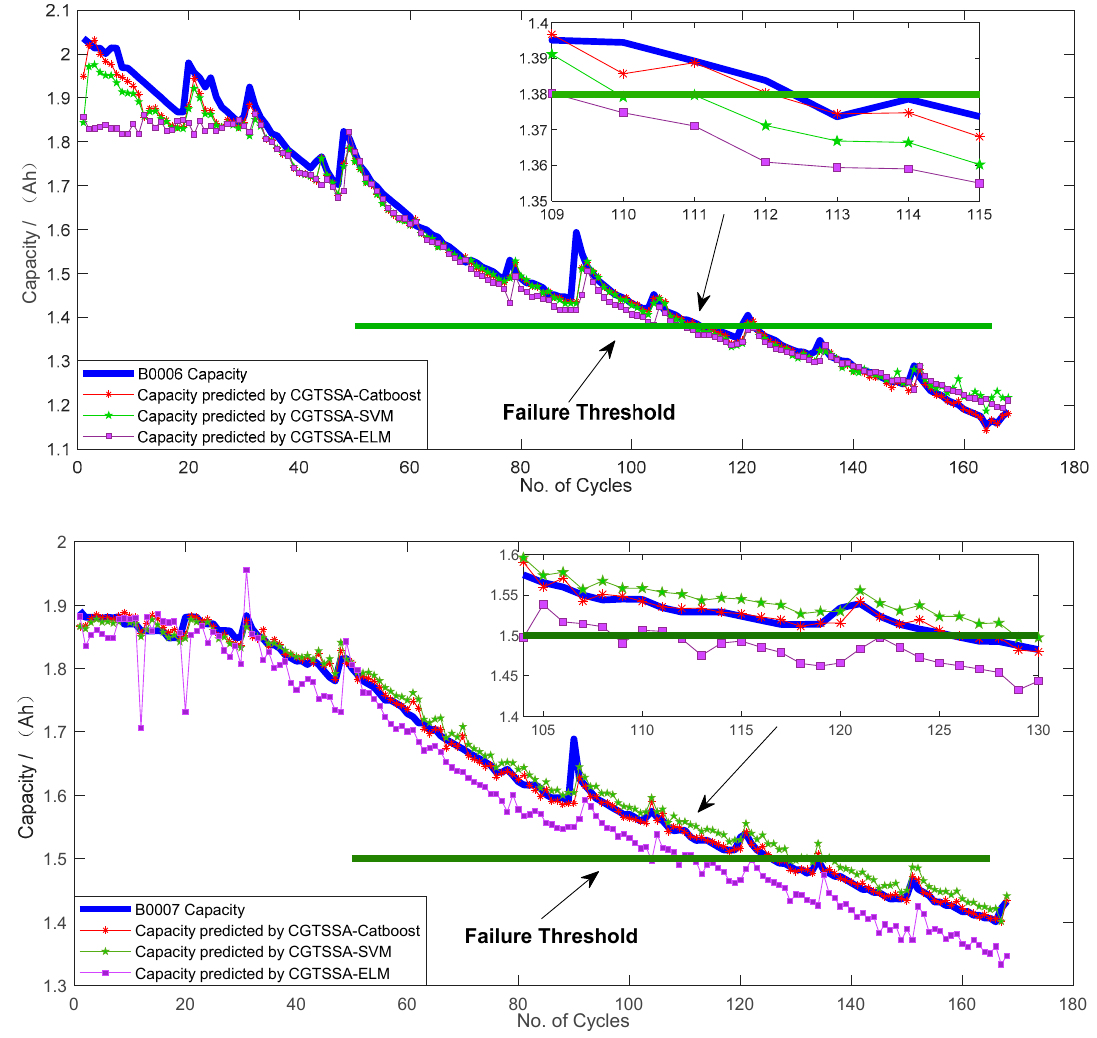
Figure 8. Comparison results of multiple models.